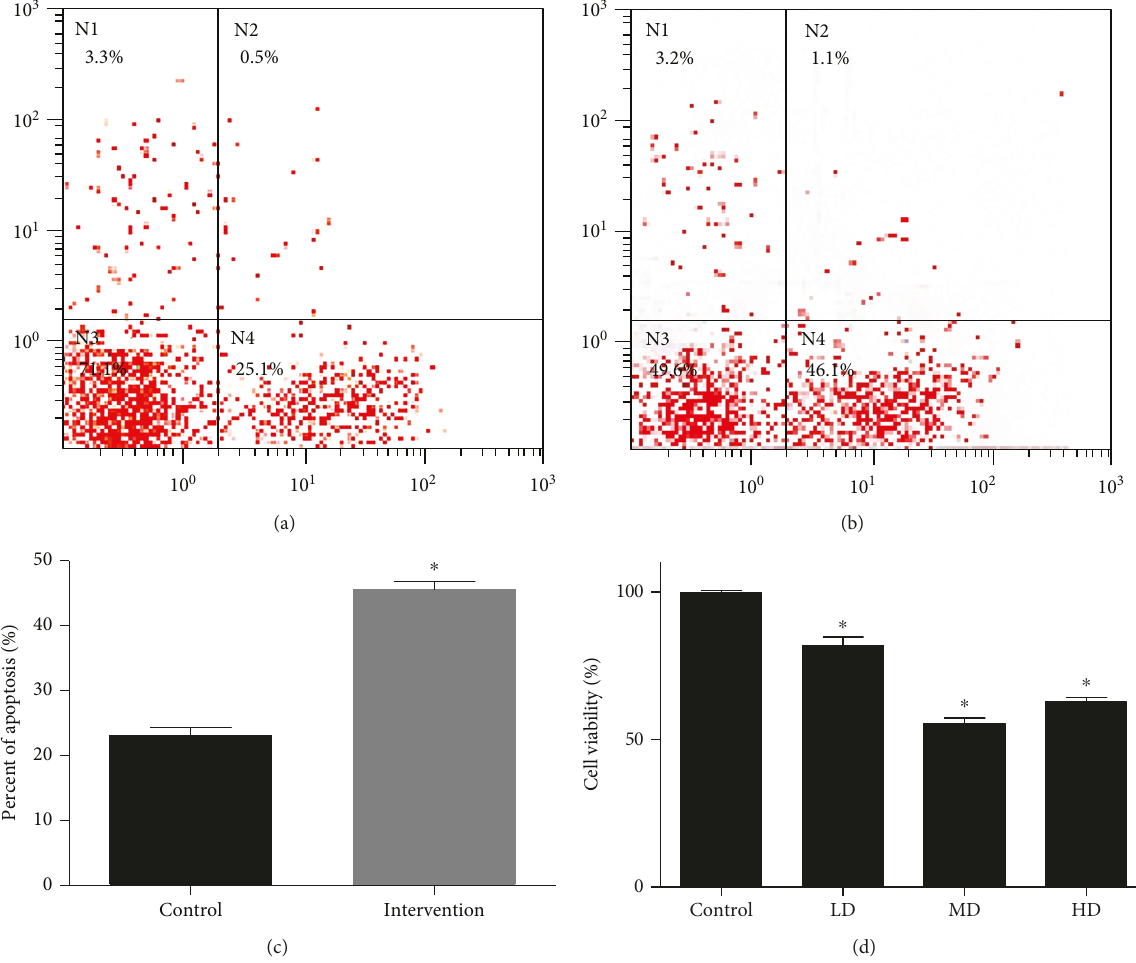
Figure 2: Flow cytometry assay and CCK-8 assay for prostatic cancer cells. (a, b) The representative data of fl ow cytometry assay for apoptosis of cell line PC-3. (c) The average percent of apoptosis of PC-3 cells was calculated. (d) CCK-8 results for tumor cells in mice. All experiments were triplicated. Data were presented as mean ± SD . ∗ p < 0 05 , compared with the control group.